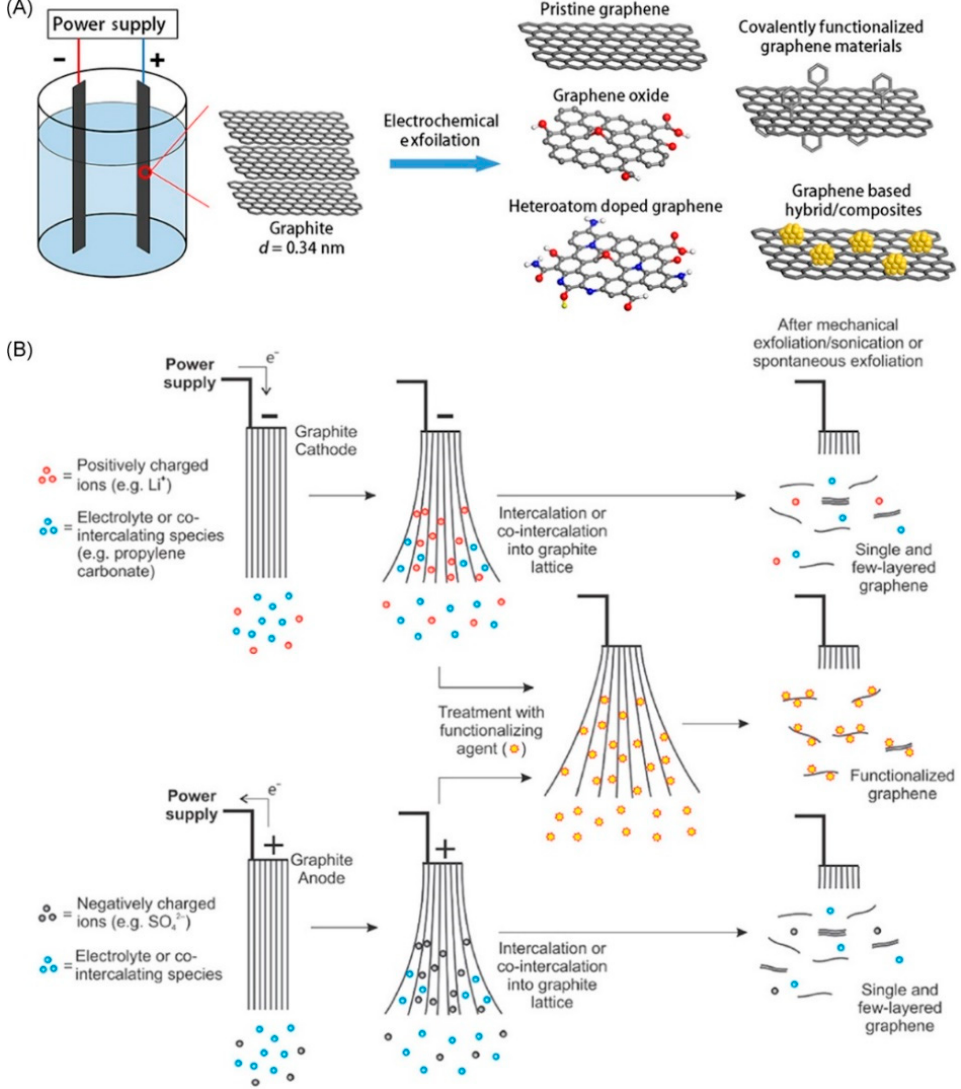
Figure 6. ( A ) Illustration for electrochemical exfoliation of graphite to produce various graphene materials; ( B ) schematic of cathodic and anodic exfoliation mechanisms. Reprinted with permission from [66,67]. Copyright@ Elsevier and John & Wiley Inc., respectively.